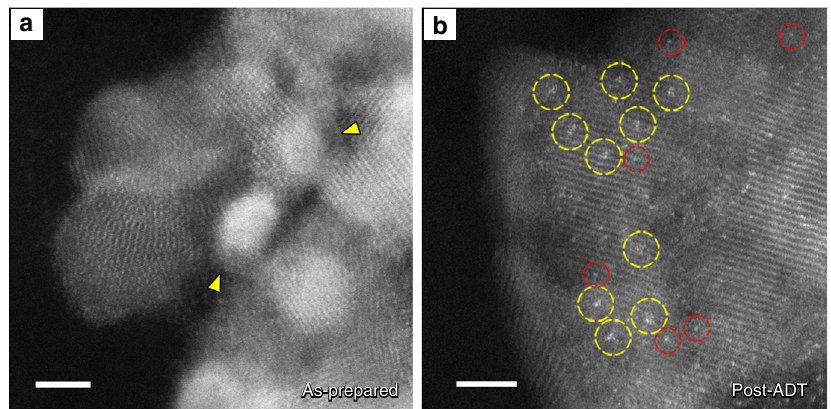
Fig. 5 Dispersion of Pt trimer species on the Co-Pd surface. a High angle annular dark fi eld-scanning transmission electron microscopy (HAADF-STEM) image of the as-prepared Pt-decorated Co-Pd (Co@Pd-Pt) catalyst. Yellow arrows indicate the agglomerated Pt trimer species. Scale bar: 2 nm. b HAADF- STEM image of the Co@Pd-Pt catalyst after 310,000 accelerated degradation test (ADT) cycles. Yellow and red circles indicate the dispersed Pt trimer species and single Pt atoms, respectively. Scale bar: 2